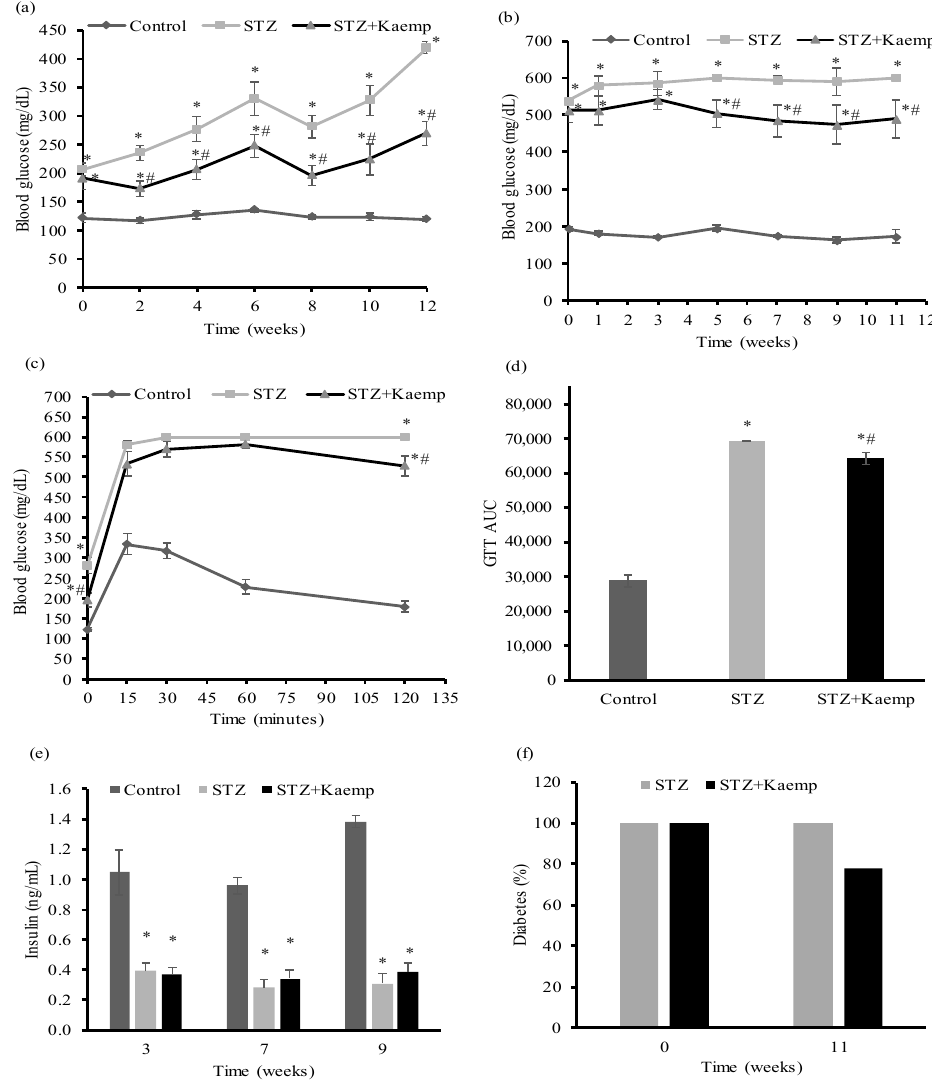
Figure 1. Oral administration of kaempferol improved glucose control in STZ-induced diabetic mice. ( a ) Fasting and ( b ) non-fasting blood glucose levels were measured at indicated time points during 12 weeks of kaempferol treatmnet. GTT ( c ) was performed as described in the Method section after 6 weeks of kaempferol treatment. The area under the curve (AUC) for GTT ( d ) was calculated. ( e ) Non-fasting blood was withdrawn at week 3, 7, and 9 after treatment for measuring plasma insulin levels. ( f ) The percentage of mice with non-fasting blood glucose levels of >300 mg/dL was calculated at the beginning and after 11 weeks of kaempferol treatment. Data are shown as Mean ± SEM ( n = 9). * p < 0.05 vs. non-diabetic mice; # vs. STZ-induced diabetic mice. Control: nondiabetic mice; STZ: STZ-induced diabetic mice; STZ + Kaemp: STZ-induced diabetic mice treated with kaempferol (50 mg/kg